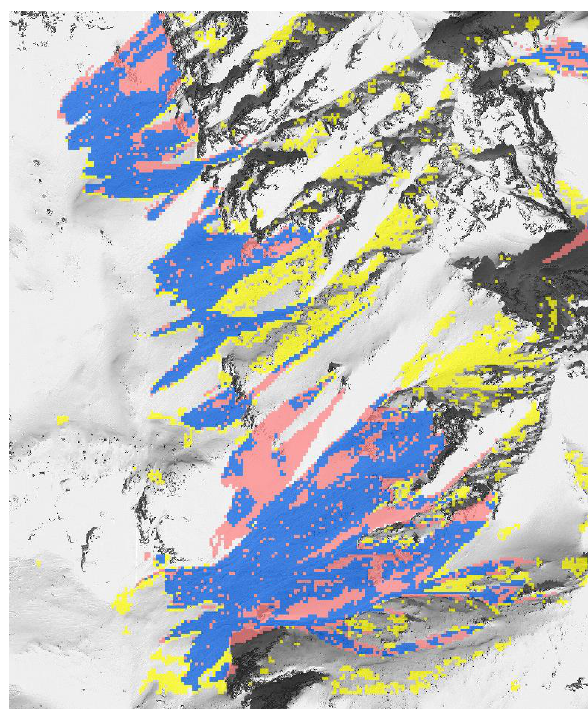
Figure 8: Quantitative comparison between expert mapping and algorithm performance. Blue = mapped as avalanche snow by both methods; red = only mapped as avalanche snow by manual method; yellow = only mapped as avalanche snow by algorithm. (Satellite image: Copyright ©